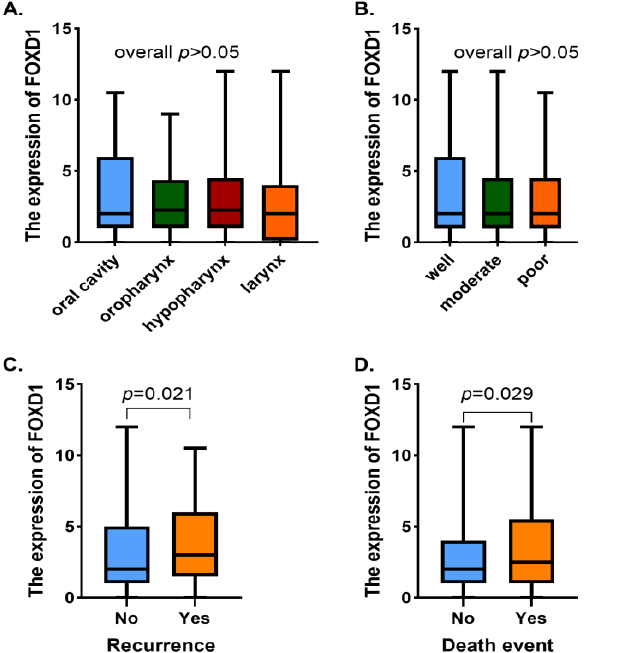
Figure 2. Representative immunohistochemical staining of FOXD1 in HNSCC TMAs. High expres-